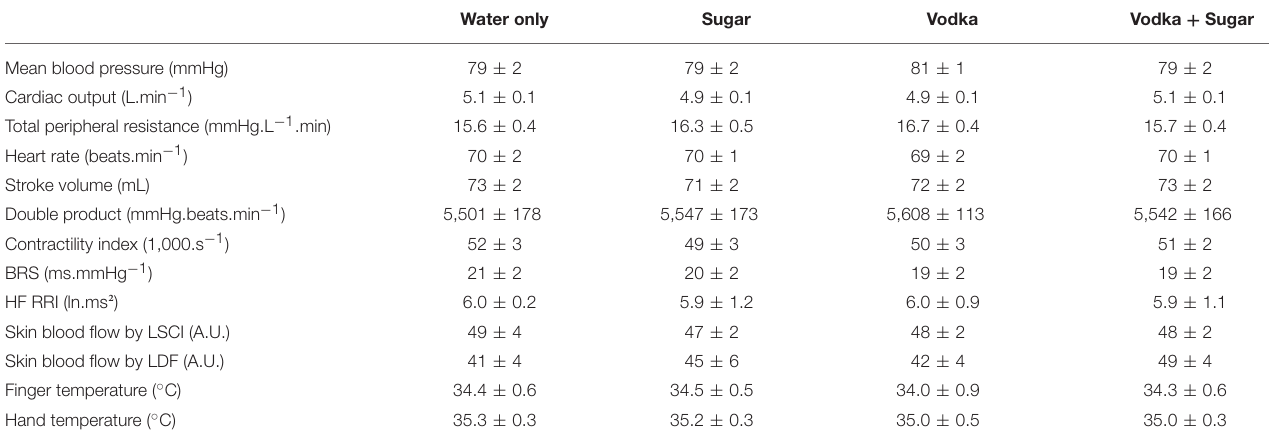
TABLE 1 | Baseline hemodynamic and cutaneous data recorded prior to drink ingestion.